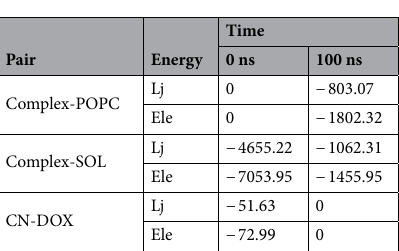
Table 2. Average electrostatic (Ele) and van der Waals (Lj) interaction energies between the different components of the investigated system.